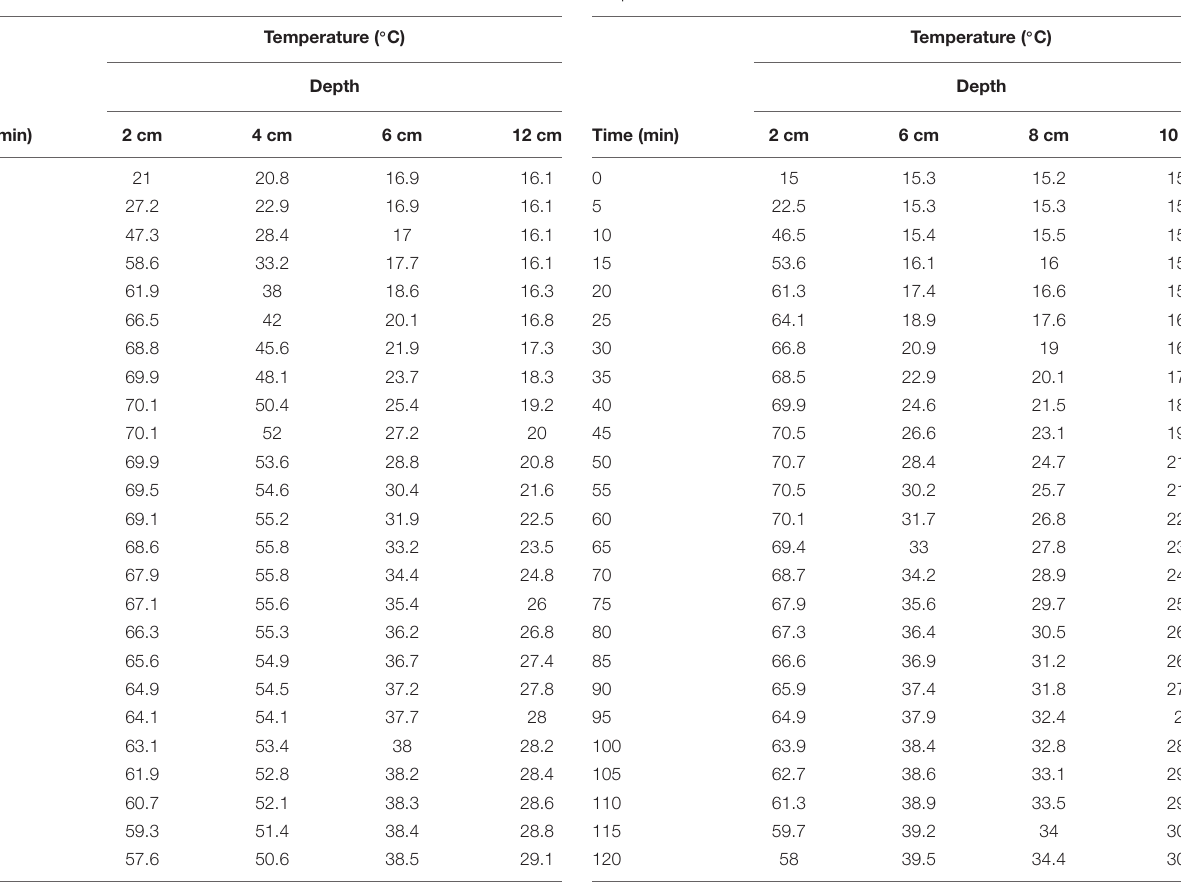
TABLE 5 | The third group of temperature data; air temperature 12 ◦ C, HMA temperature 155 ◦